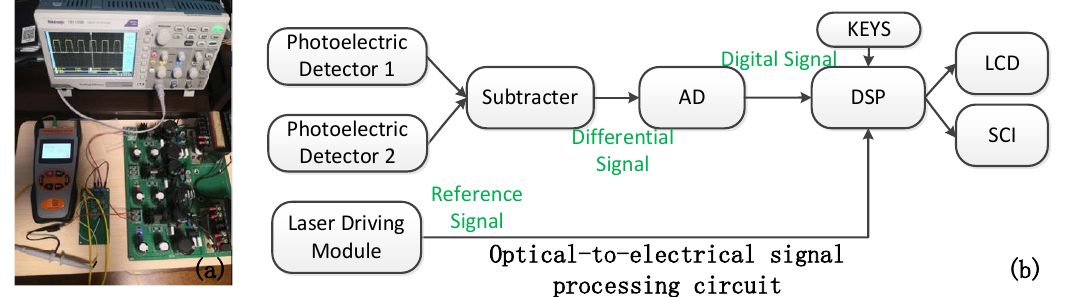
Figure 4. Performance test of the optimized photovoltaic conversion circuit with two InGaAs photodiodes ( a ) and the schematic of the photovoltaic conversion and signal processing ( b ).